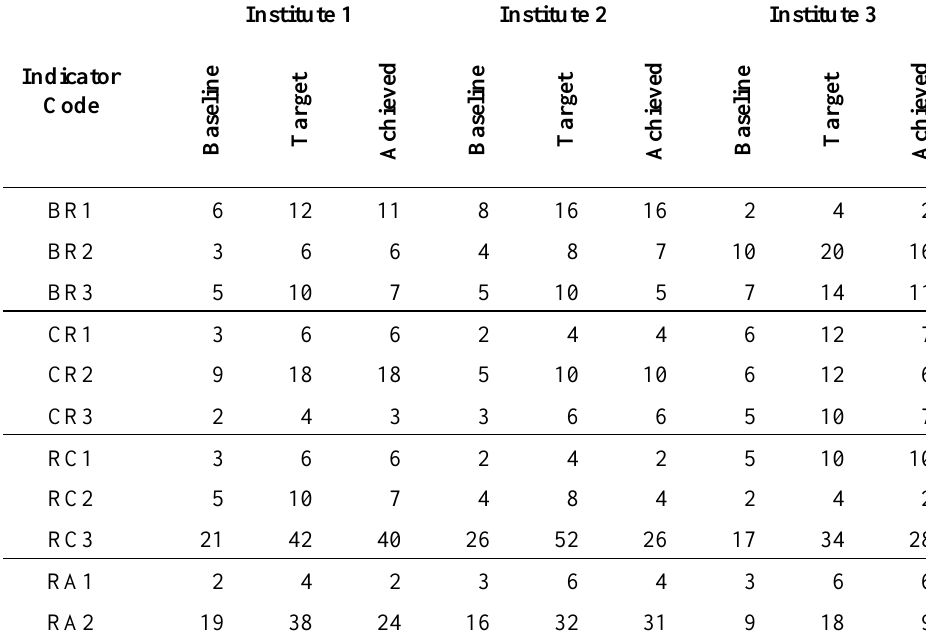
Table 4: Baseline Data Value, Target Data Value and Achieved Data Value of